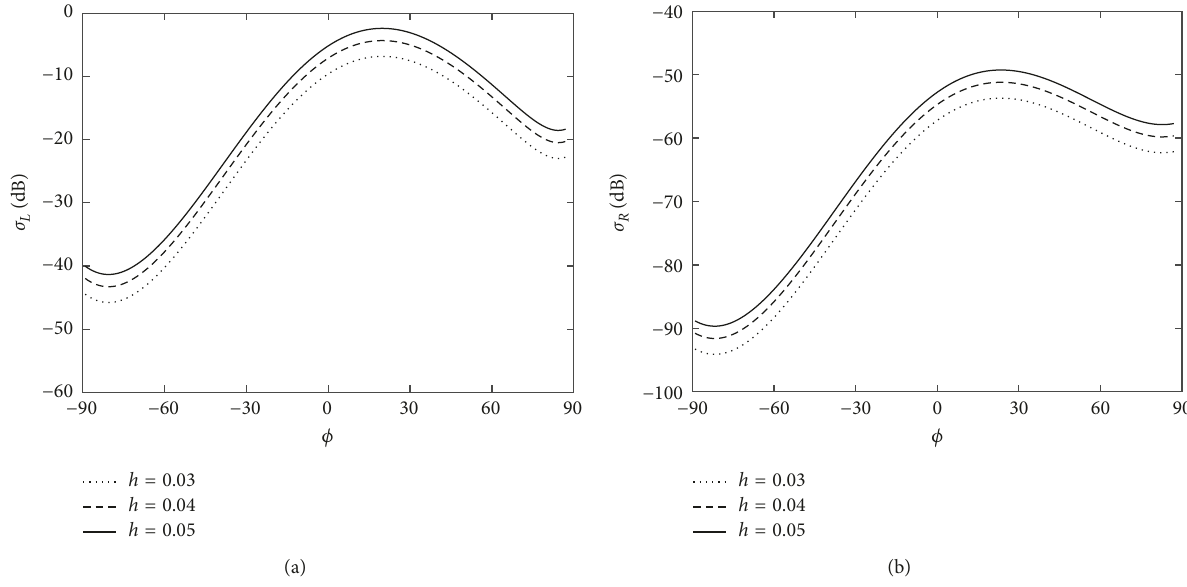
Figure 3: LCP and RCP scattering coefficients for different values of rms height, where φ